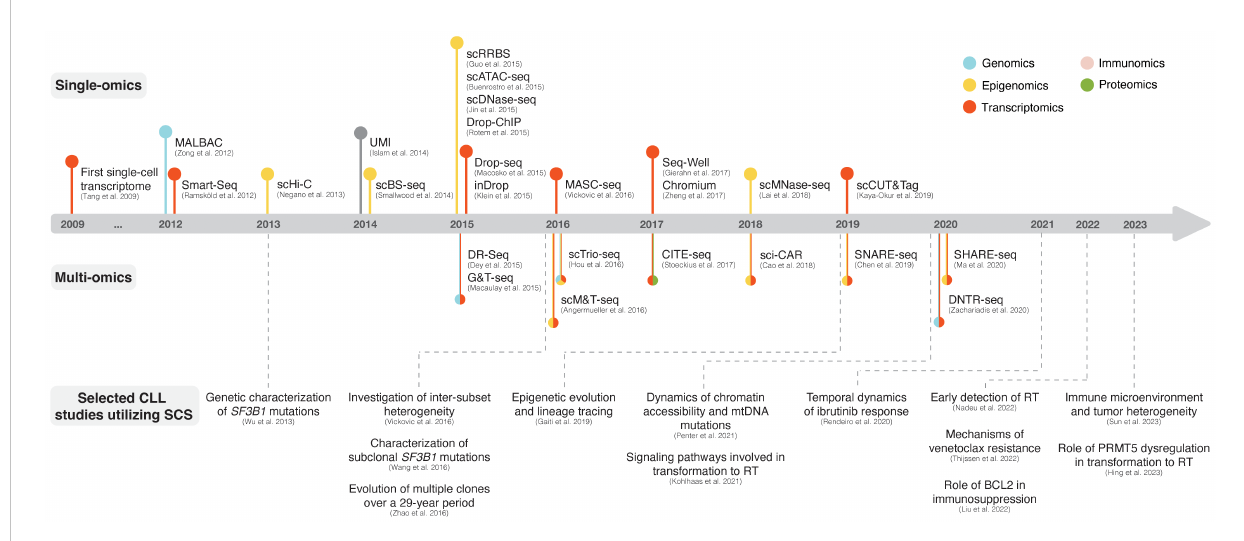
FIGURE 4 The advent of SCS technologies with selected examples of CLL studies. The respective panels above and below the timeline showcase various single-omics and multi-omics technologies that have been developed over the last decade. Selected CLL studies where SCS was employed are exempli fi ed in the lower part of the fi